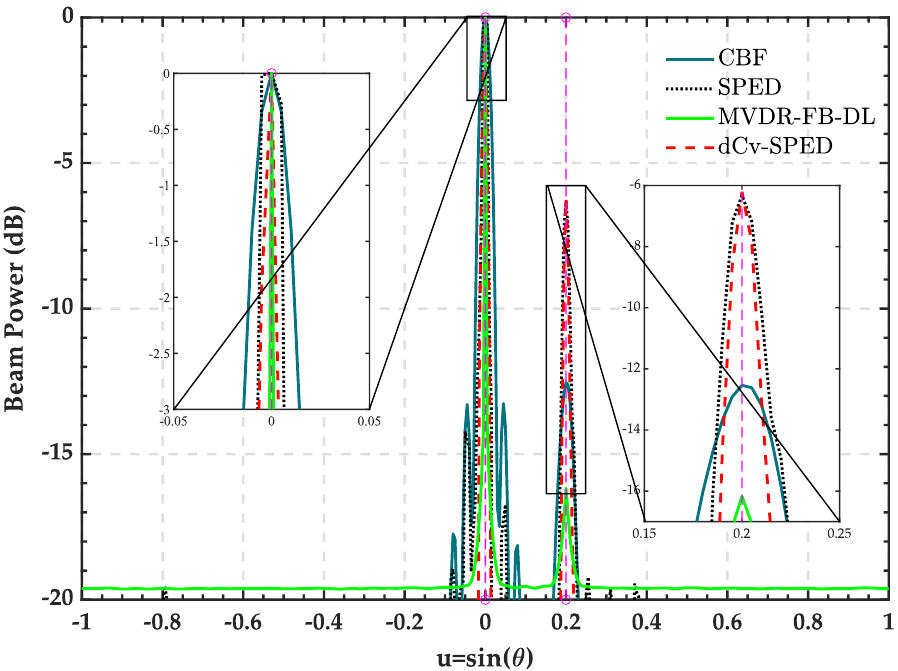
Figure 2. Spatial spectra estimated by CBF, SPED, MVDR-FB-FL, and dCv-SPED. In the second simulation, we investigated the root mean square error (RMSE) and resolution probability of the direction in the u-space of the two sources versus the input noise power using 200 Monte Carlo trials. Two ship noise signals arrived at the directions of 0 ◦ [ u = sin ( 0 ◦ ) = 0] and 5.73 ◦ [ u 2 = sin ( 5.73 ◦ ) ≈ 0.1]. The power of the two targets was 20 dB (at 0 ◦ ) and 0 dB (at 5.73 ◦ ), respectively. The power of the noise varied in the interval [ − 5, 30 ] dB. For each loop, the two most energetic peaks in the spatial spectrum were chosen as the estimated direction in the u-space, ˆ u 1 and ˆ u 2 ( ˆ u 1 < ˆ u 2 ) , and the RMSE